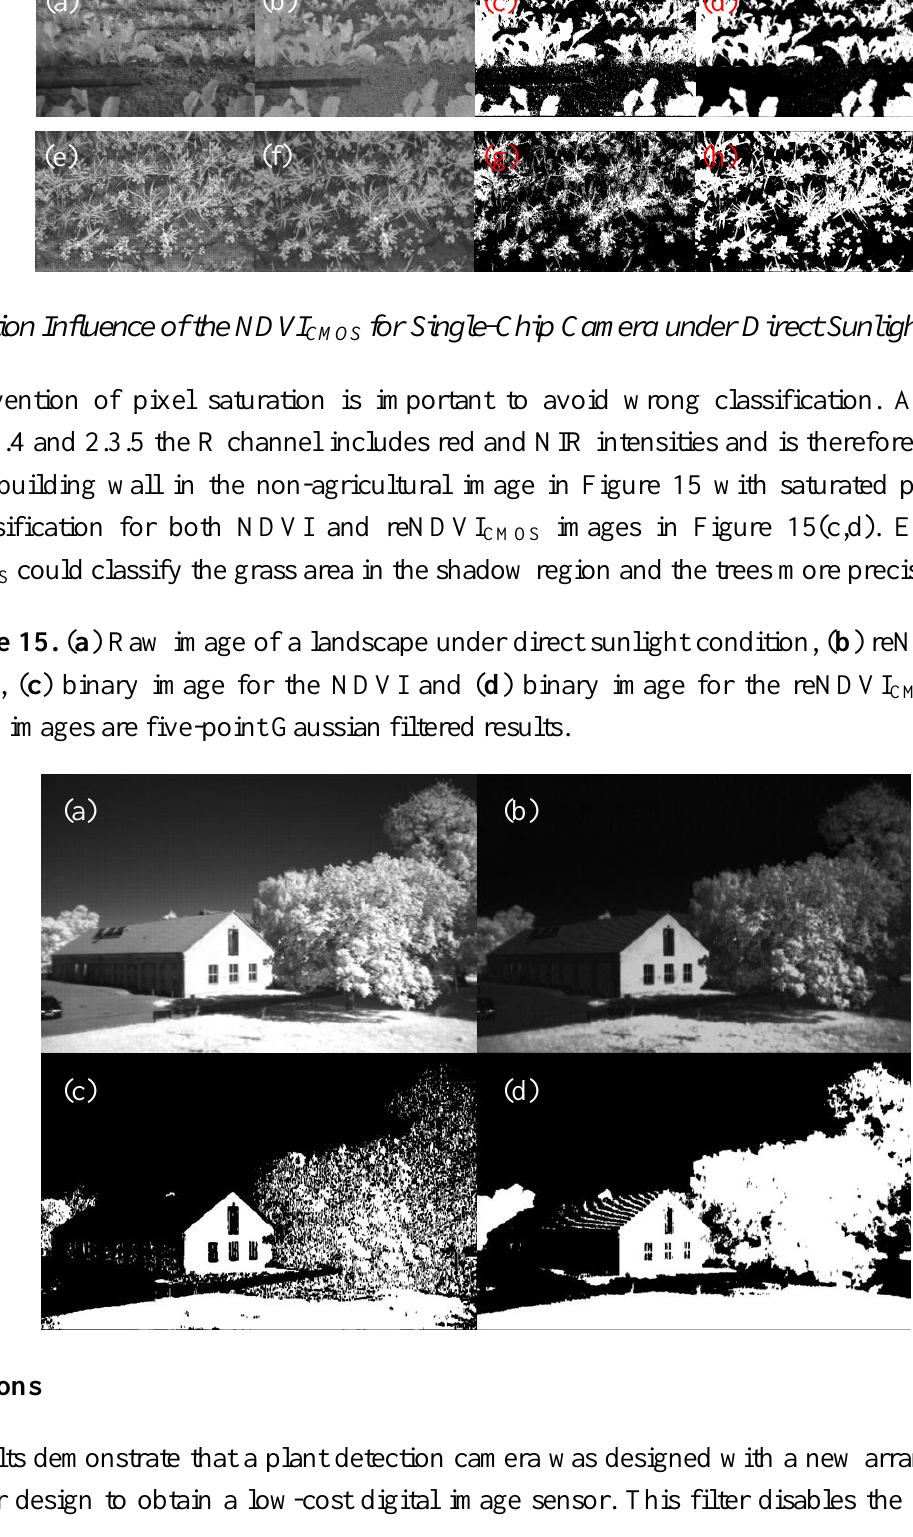
Figure 14. ( a ) Raw image of a salad field (by courtesy of Cruse Leppelmann Kognitionstechnik GmbH), ( b ) reNDVI image, ( c ) binary image of the NDVI, ( d ) binary image of the reNDVI, ( e ) raw image of winter wheat in the early growths state by Potsdam, Germany, ( f ) reNDVI image, ( g ) binary image of the NDVI, and ( h ) binary image of the reNDVI. All binary images are five-point Gaussian filtered results.